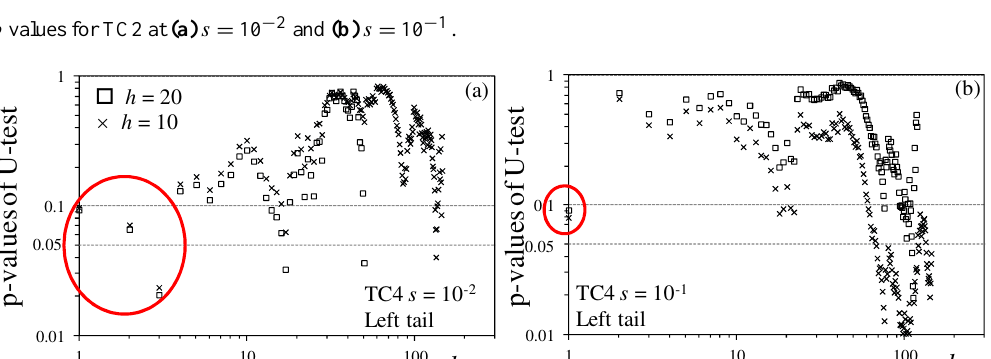
Fig. 7. U test p values for TC2 at (a) s = 10 − 2 and (b) s = 10 − 1 .